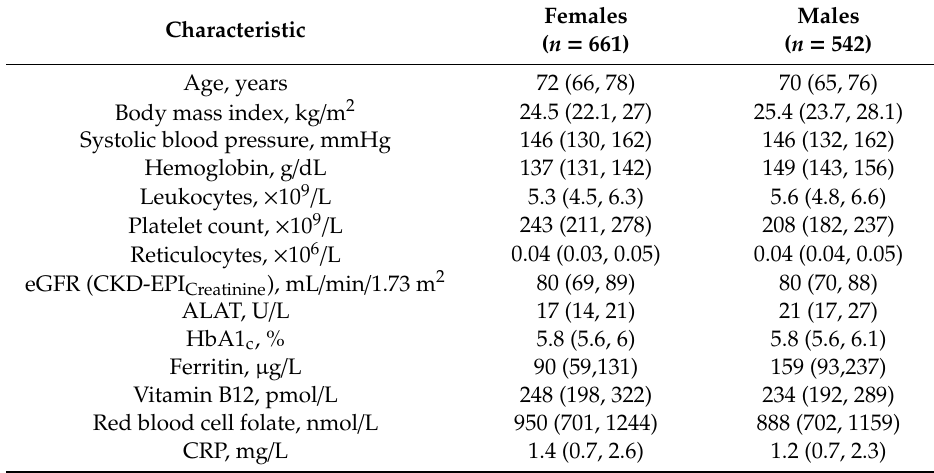
Table 1. Baseline characteristics of participants included in direct reference interval determination for platelet count. Summary statistics are given as medians with interquartile range (IQR).